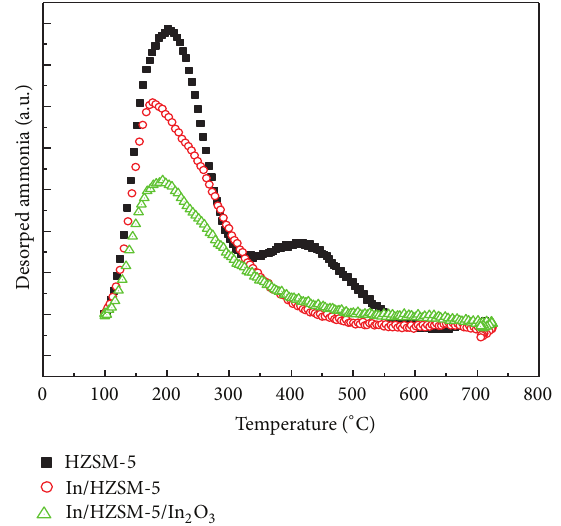
Figure 12: NH 3 -TPD profiles over HZSM-5, In/HZSM-5, and In/HZSM-5/In 2 O 3 .